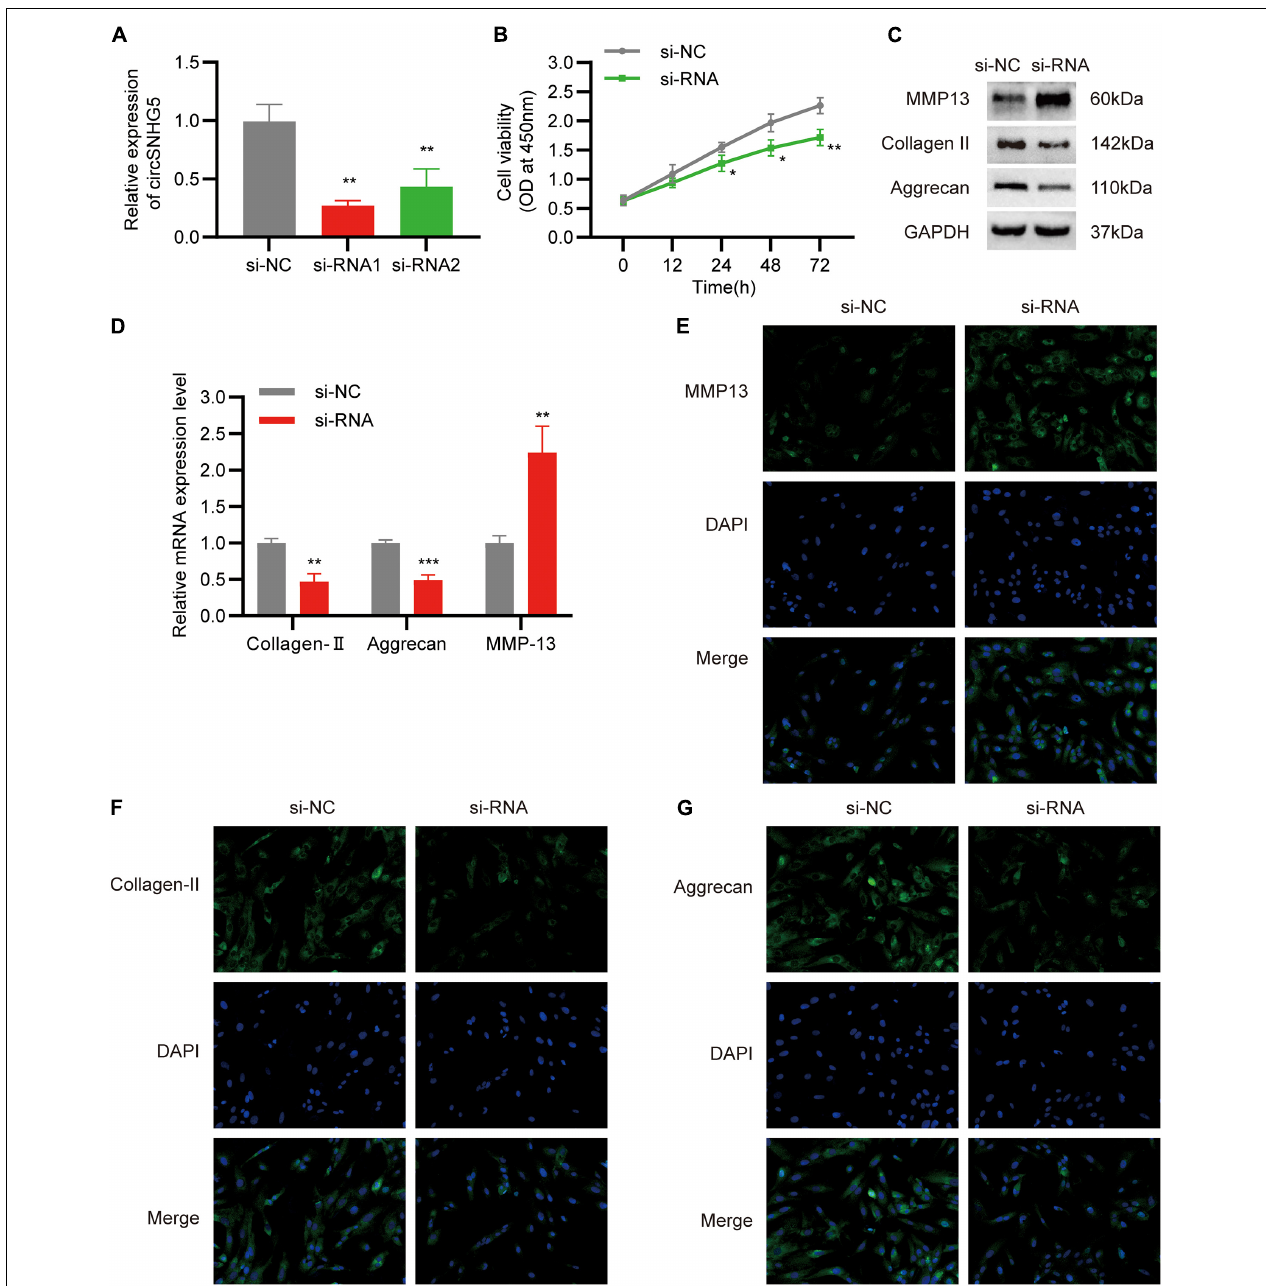
FIGURE 2 | Silencing circSNHG5 leads to functional depletion. (A) Expression analyses of circSNHG5 knockdown efficiency by two different siRNAs in chondrocytes (** P < 0.01). (B) The effect of circSNHG5 on cell proliferation was determined by CCK8 assay (* P < 0.05, ** P < 0.01). (C) Western blot analysis of MMP13, Collagen II, and Aggrecan when circSNHG5 was downregulated. The optical density analysis was performed from the results of three independent experiments of Western blot samples. (D) Relative mRNA expression test by qRT-PCR (** P < 0.01, *** P < 0.001). (E–G) Immunofluorescence (IF) staining for MMP13, Collagen II, and Aggrecan after transfection with siRNA. Scale bar, 40 µ